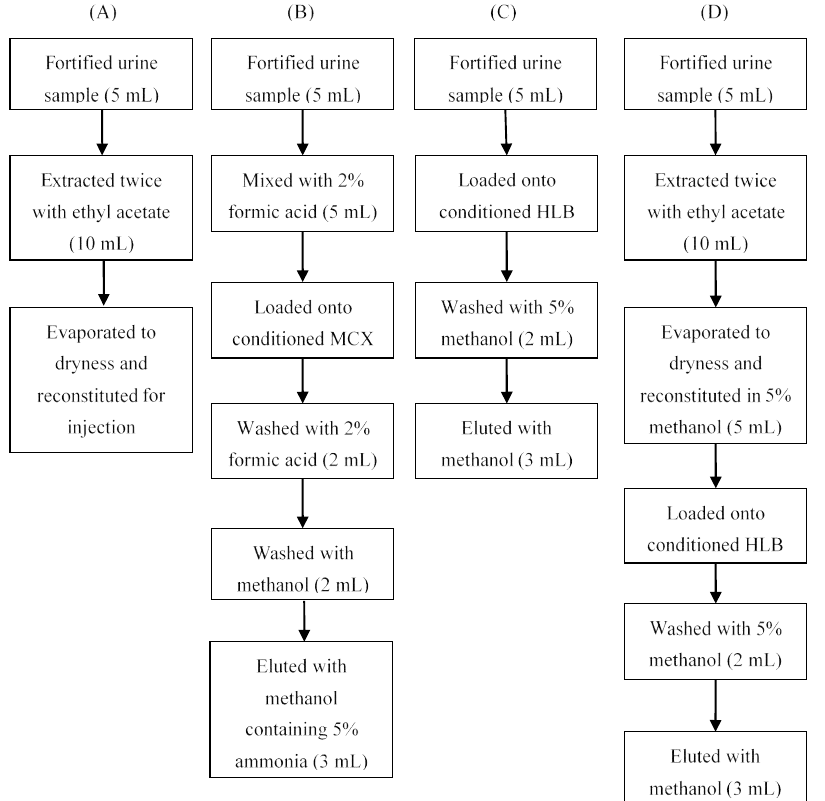
Figure 1. Optimization of sample preparation. HLB, MCX.